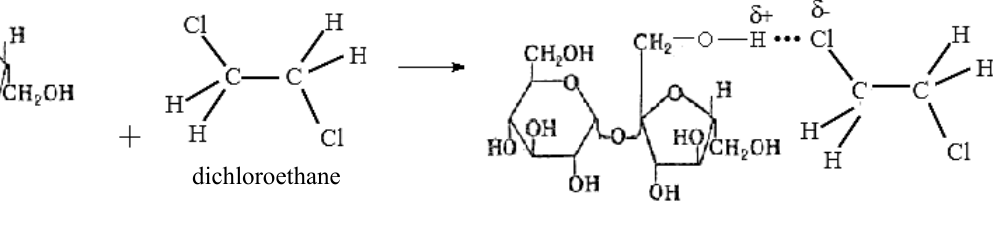
Fig. 3. Chemical interaction of contaminants with sucrose.